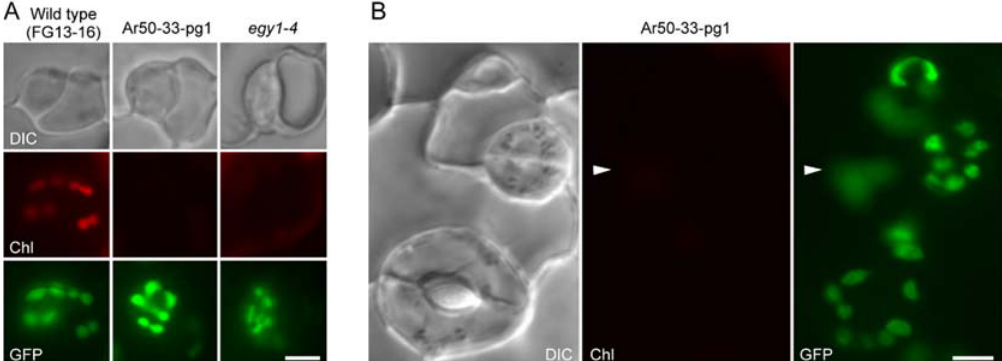
Figure 6. Fluorescence microscopy of leaf guard mother cells in the wild-type and mutant lines expressing PDF1 p:: TP SIG6 -GFP . ( A , B ) DIC, chlorophyll autofluorescence (Chl), and GFP images of guard mother cells ( A ) and late stomatal lineage cells ( B ) in the abaxial leaf epidermal peels of the third and fourth expanding leaves of 18-day-old seedlings. Arrowheads in ( B ) correspond to those in Figures 4 and S6 and indicate pavement cell chloroplasts. Chl images in ( A , B ) were captured under the same microscopic conditions. Bar = 5 µm.